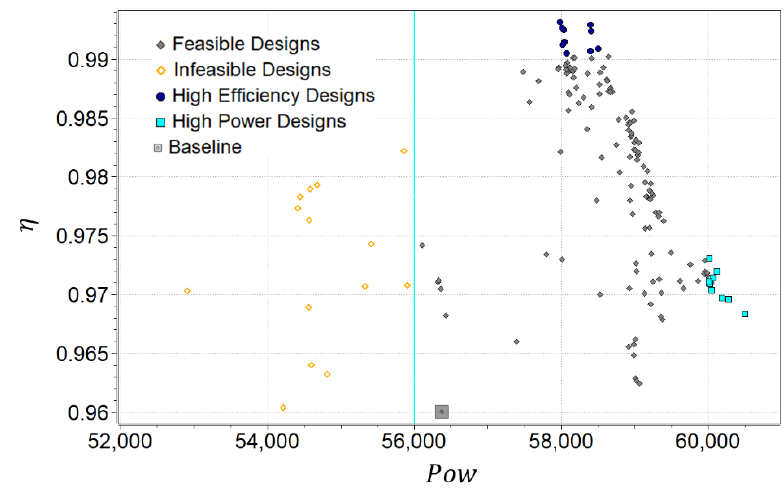
Figure 7. Efficiency vs. power for all designs points in the optimization study.